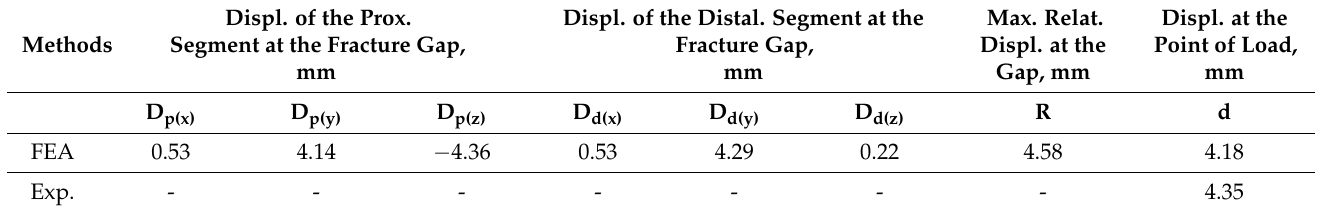
Table 3. Values of displacements under maximum intensity of load. Methods